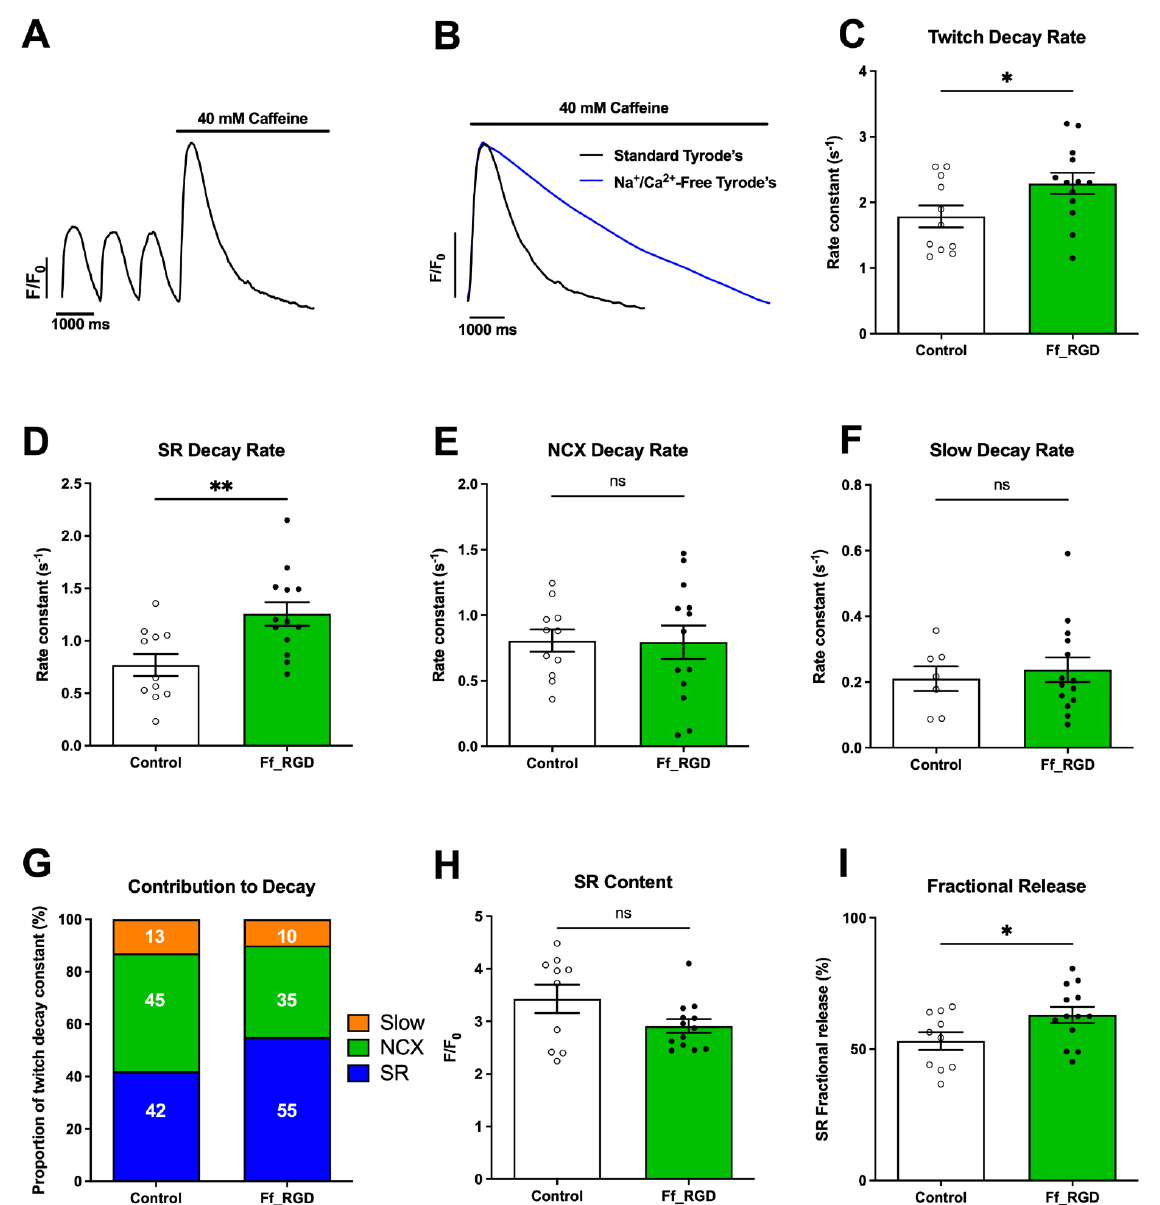
Figure 2. Integrin ligands recruit the sarcoplasmic reticulum (SR) for Ca 2+ cycling at 1 Hz field − stim- ulation. ( A ) Representative trace of three 1 Hz field − stimulated (twitch) Ca 2+ transients followed by caffeine response (see Movie S5). ( B ) Representative traces showing response to caffeine in Na + /Ca 2+ - free and standard Tyrode’s solution. Data illustr ated as means ± SEM. Parameters were rate of ( C ) twitch Ca 2+ transient decay (* p = 0.0446), ( D ) SR Ca 2+ uptake (** p = 0.0049), ( E ) sodium/calcium exchanger (NCX) − mediated Ca 2+ removal (ns p = 0.941), ( F ) Ca 2+ removal mediated via mitochon- drial Ca 2+ − uniporter and sarcolemma Ca 2+ − ATPase activity (slow) (ns p = 0.856). Rates of removal mechanisms were used to calculate ( G ) percentage contribution of Ca 2+ removal mechanisms. ( H ) SR Ca 2+ content (ns p = 0.376). ( I ) Fractional release of SR Ca 2+ stores (* p = 0.0426) (Panel C, D, E, H, I — n = 11 control, n = 13 ff_RGD images with averaged signal from within the camera field of view from at least four batches. Panel F n = 10 control, n = 14 ff_RGD images with averaged signal from within the camera field of view from at least four batches). Cardiomyocytes were used at day 40 – 46 of differentiation.